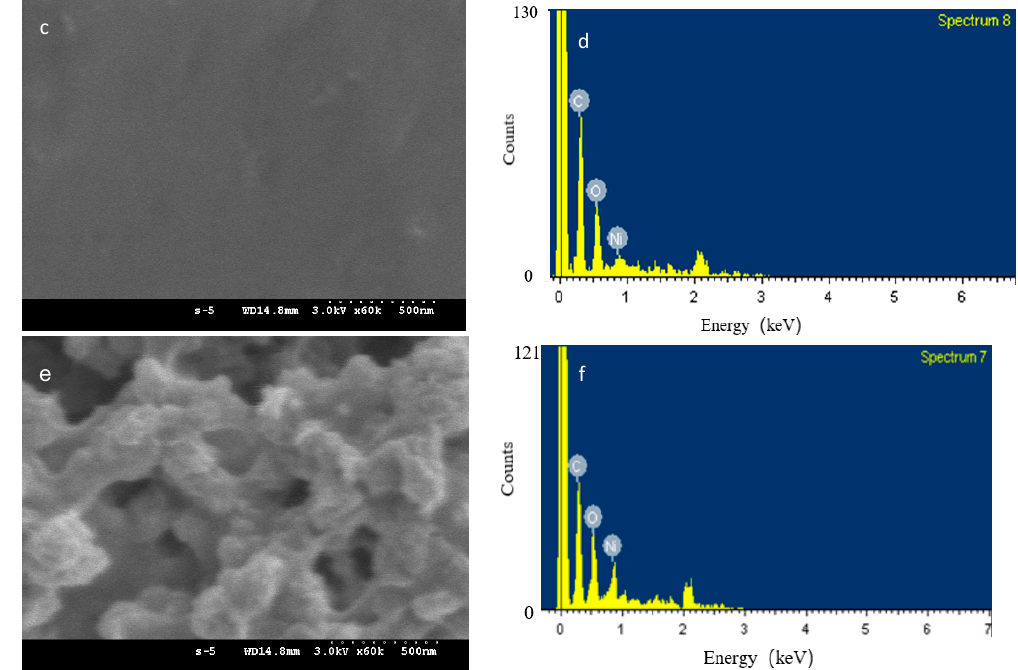
Figure 2. FESEM micrograph of ( a ) Ni-NPs; ( b ) PVA gel; ( c ) PVA gel containing 2.3% Ni; ( d ) EDX spectrum of PVA gel containing 2.3% Ni; ( e ) PVA gel containing 4.5% Ni; and ( f ) EDX spectrum of PVA gel containing 4.5% Ni.